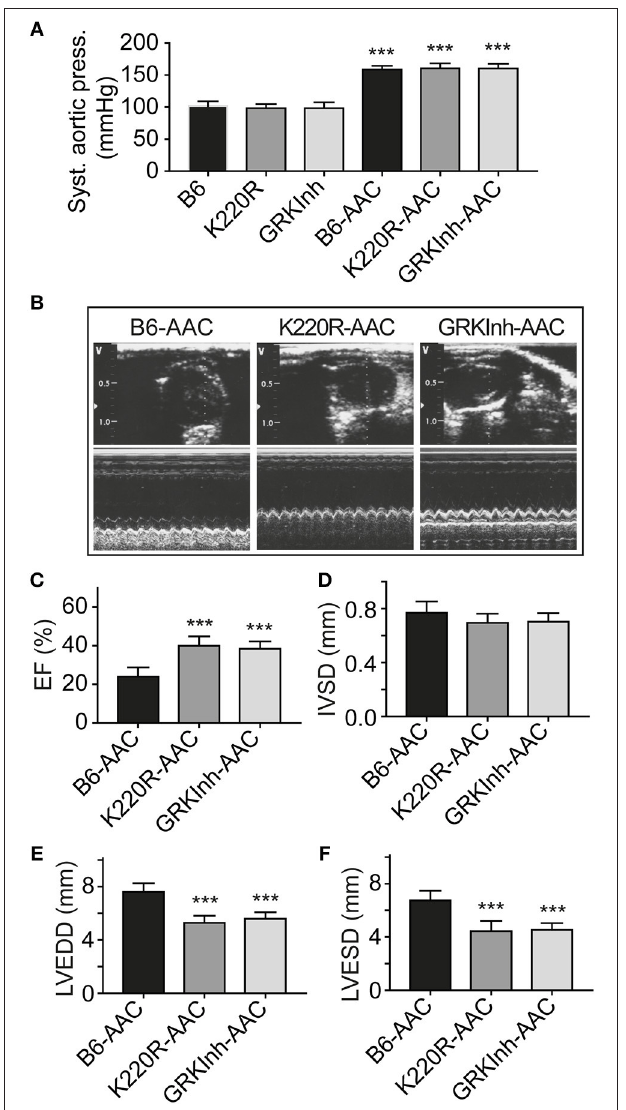
FIGURE 11 | Dominant-negative GRK2-K220R retards chronic pressure overload-induced cardiac dysfunction. (A) Systolic aortic pressure of B6, Tg-K220R and Tg-GRKInh mice under basal conditions and at the end of the observation period after 2 months of AAC ( ± s.d.; n = 6; *** p < 0.001 vs. B6; Dunnett’s test). (B) Representative echocardiographic images in 2D mode (upper) and M-mode (lower) of B6, Tg-GRK2K220R and Tg-GRKInh mice with 2 months of chronic pressure overload imposed by AAC. (C–F) Left ventricular ejection fraction (C) , interventricular septal thickness (D) , LVEDD (E) and LVESD (F) were determined by echocardiography of B6, Tg-GRK2K220R and Tg-GRKInh mice at the end of the observation period after 8 weeks of AAC ( ± s.d.; n = 6; *** p < 0.001; Dunnett’s test).